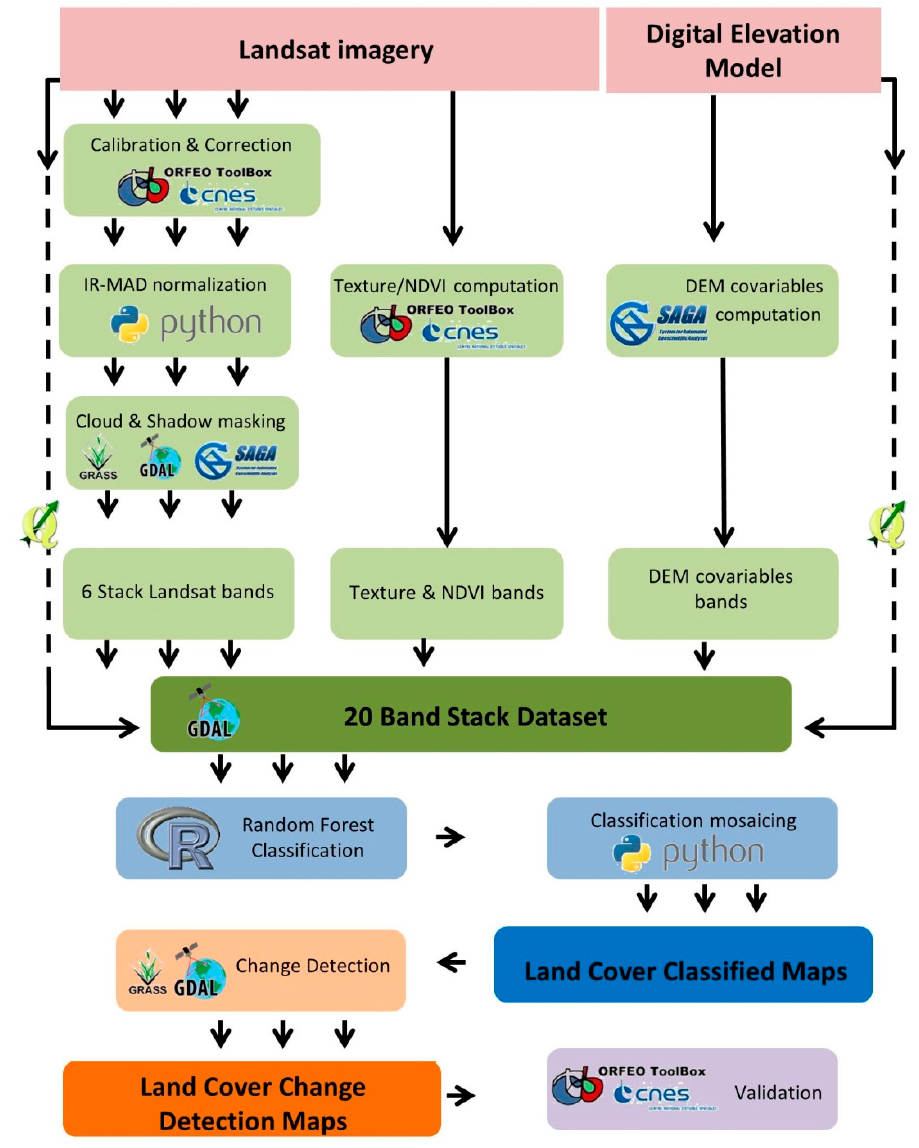
Figure 2. Methodological workflow for land cover and land cover change classification.